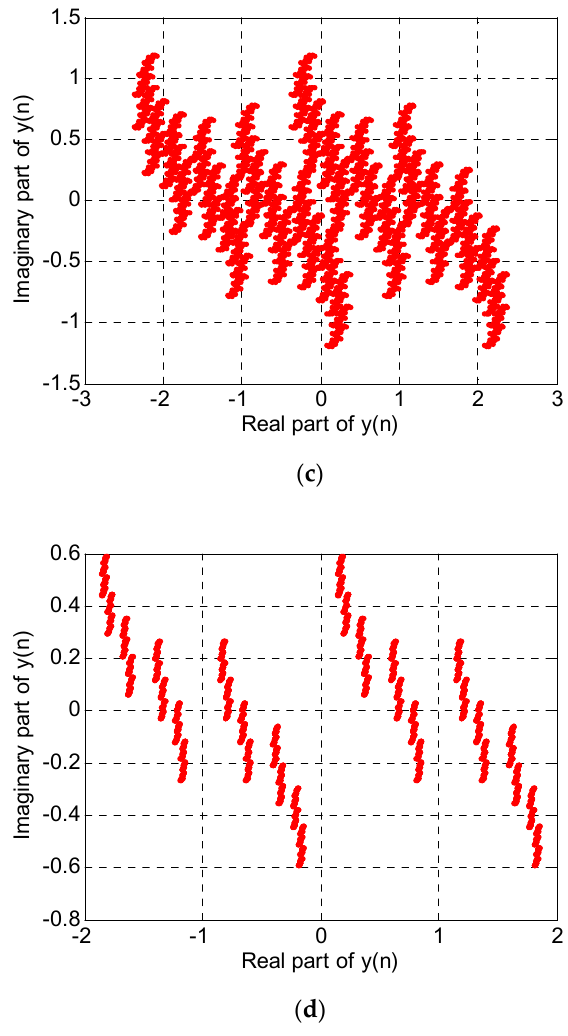
π and | λ | = 1.3. ( c ) Y with ∠ λ = 10